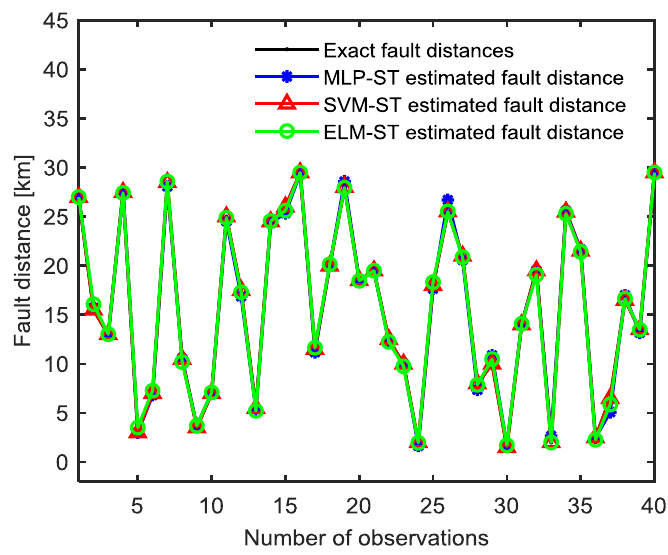
Figure 6. Comparison of the ST based constriction factor-based particle swarm optimization (CF-PSO) optimized MLT predicted and actual fault distances for the test dataset of AG fault.